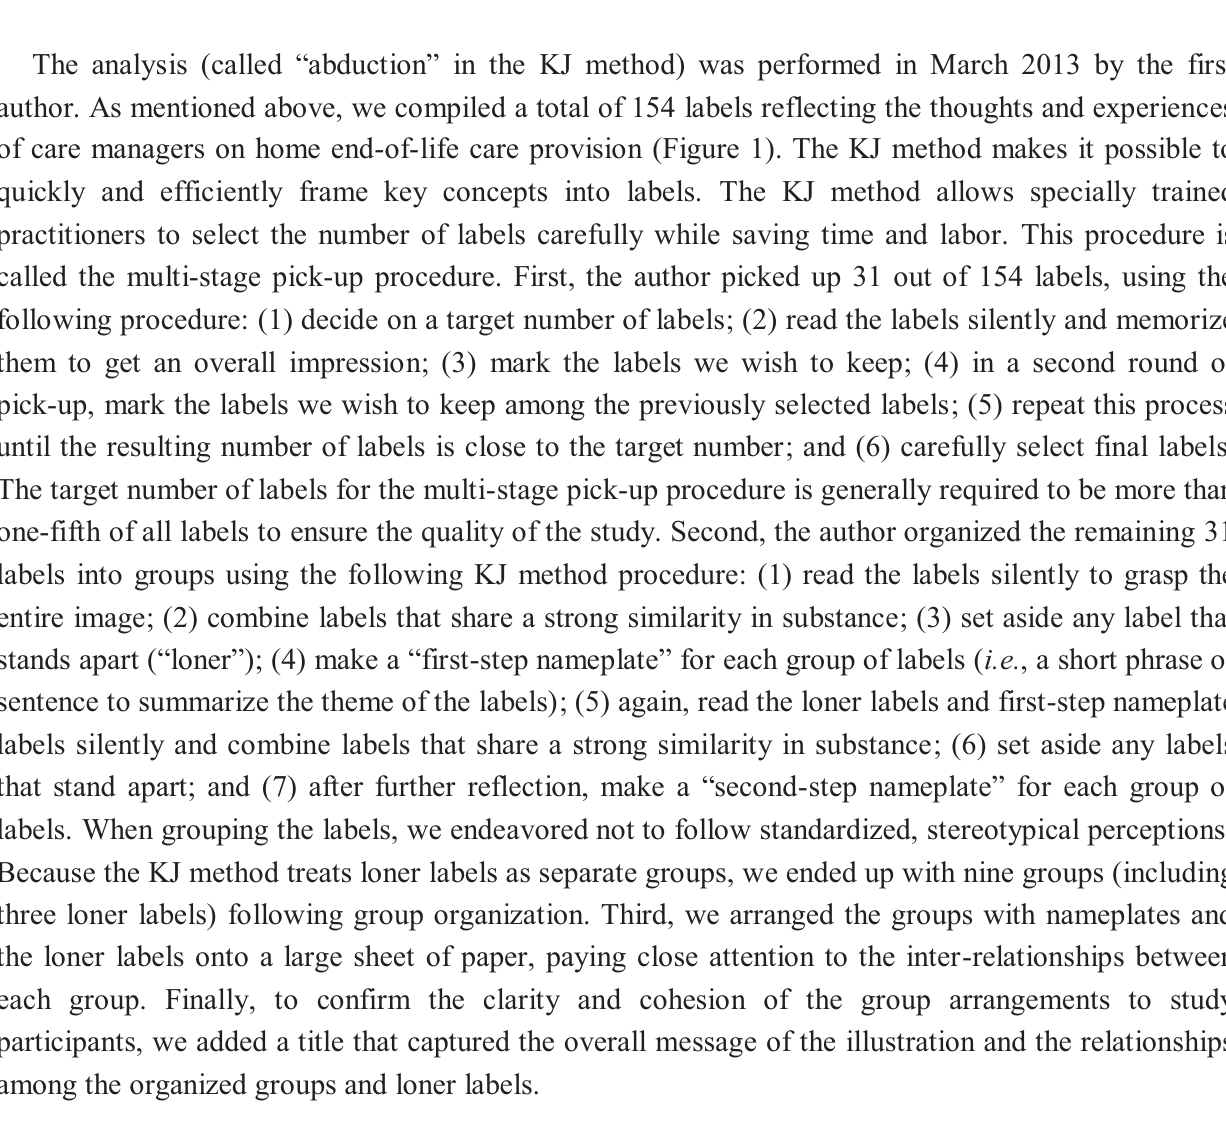
Figure 1. Procedure of KJ